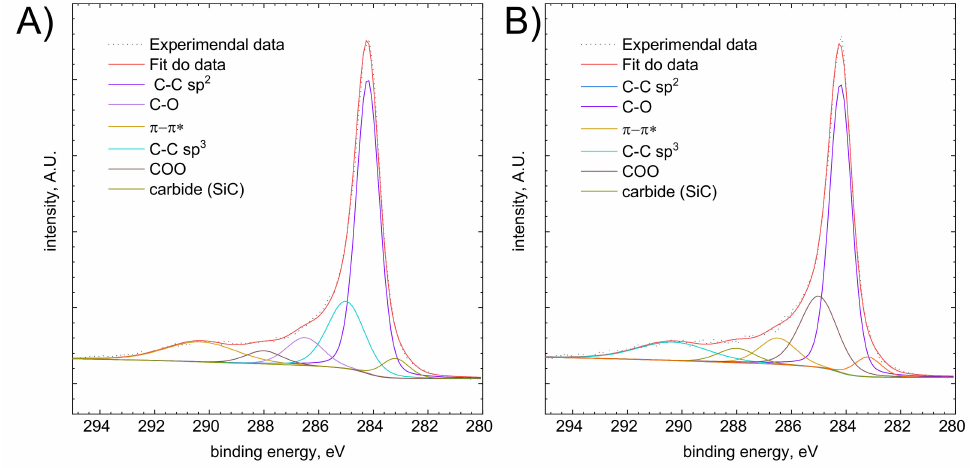
Figure 16. XPS spectrum of activated carbon, C1s line ( A ) before adsorption test, ( B ) after adsorp- tion